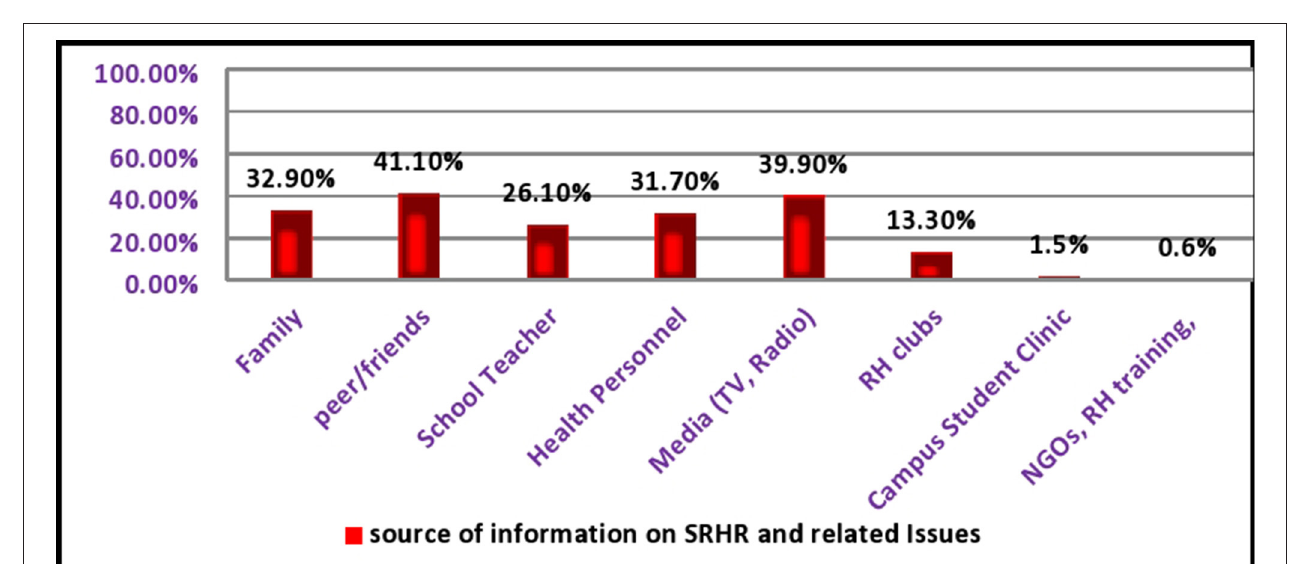
FIGURE 1 | Source of information on SRH and related